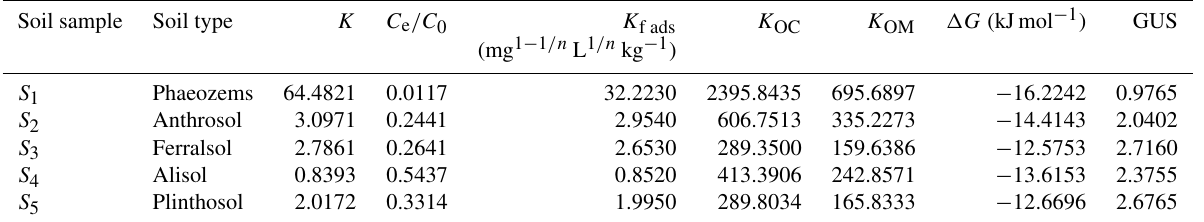
Table 2. Empirical constants, Gibbs free energy, and groundwater ubiquity score (GUS) for the adsorption of EPM in five agricultural soils. Soil